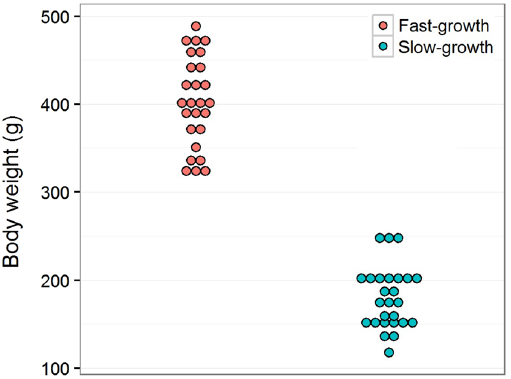
Figure 4. Sampling design. Body-weight distribution of fast- (FG) and slow- (SG) growth sampled